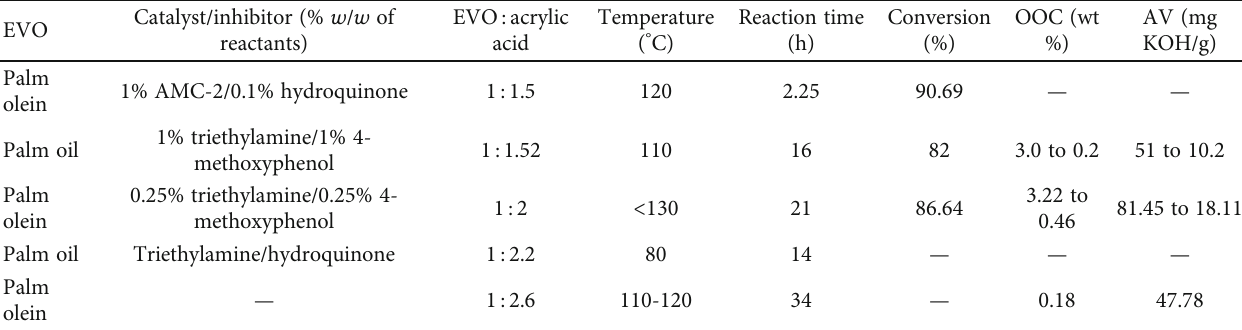
catalyst reaction. 3006 cm -1 at Jatropha seed oil spectrum The synthesis of acrylated epoxidized Jatropha seed oil